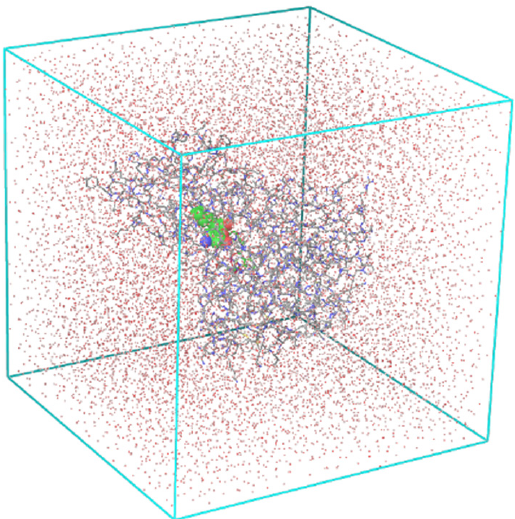
Figure 9. The periodic cubic box used in MD simulations contains the solvated Pf ENR ‐ TCL com ‐ plex.